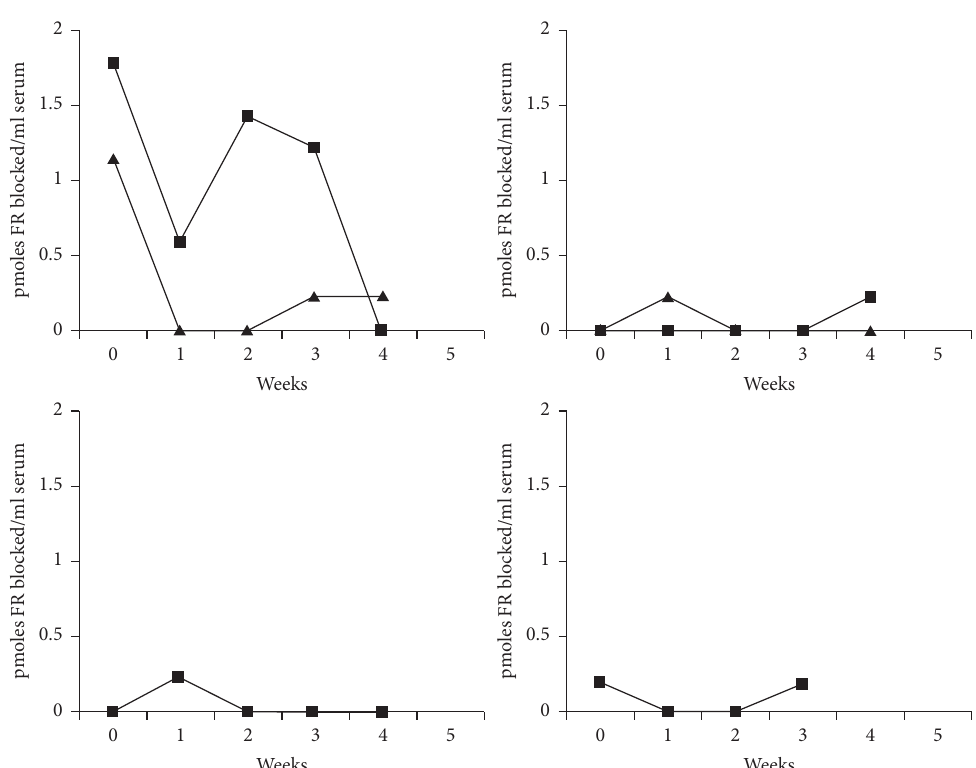
Figure 3: Fluctuations of titers for FR antibodies of the blocking type over 5 weeks in five patients with autism, with the upper left side showing two patients with high fluctuating FR antibodies of the blocking type and the upper right side showing lower FR antibody fluctuations in the identical twin pair. Both curves at the lower part represent two other patients having a minor FR antibody peak over a period of 4 to 5